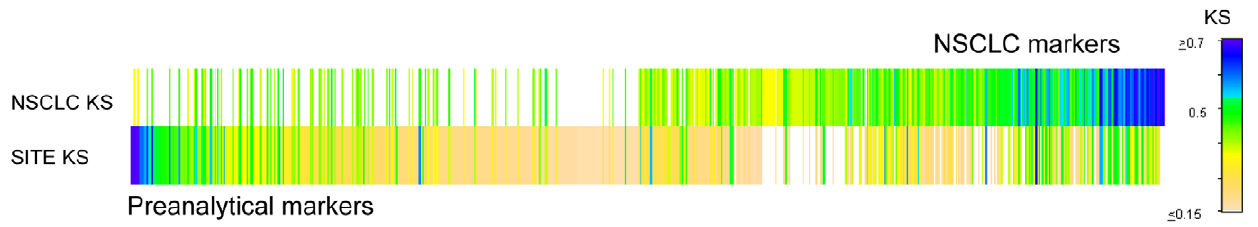
Figure 4. Heat map shows the magnitude of difference for each protein measured (columns) between subject populations for the comparison of NSCLC to controls (top row) and comparisons of cases or controls between study sites (bottom row). Top row: KS distances for NSCLC versus control distributions. Bottom row: mean KS distances for all 12 pair-wise comparisons, between the four sites, of case and control samples analyzed separately. Proteins were ordered by subtracting the NSCLC KS distance from the mean site KS distance. This revealed groups of NSCLC biomarkers (top right) contrasting with preanalytical markers (bottom left).